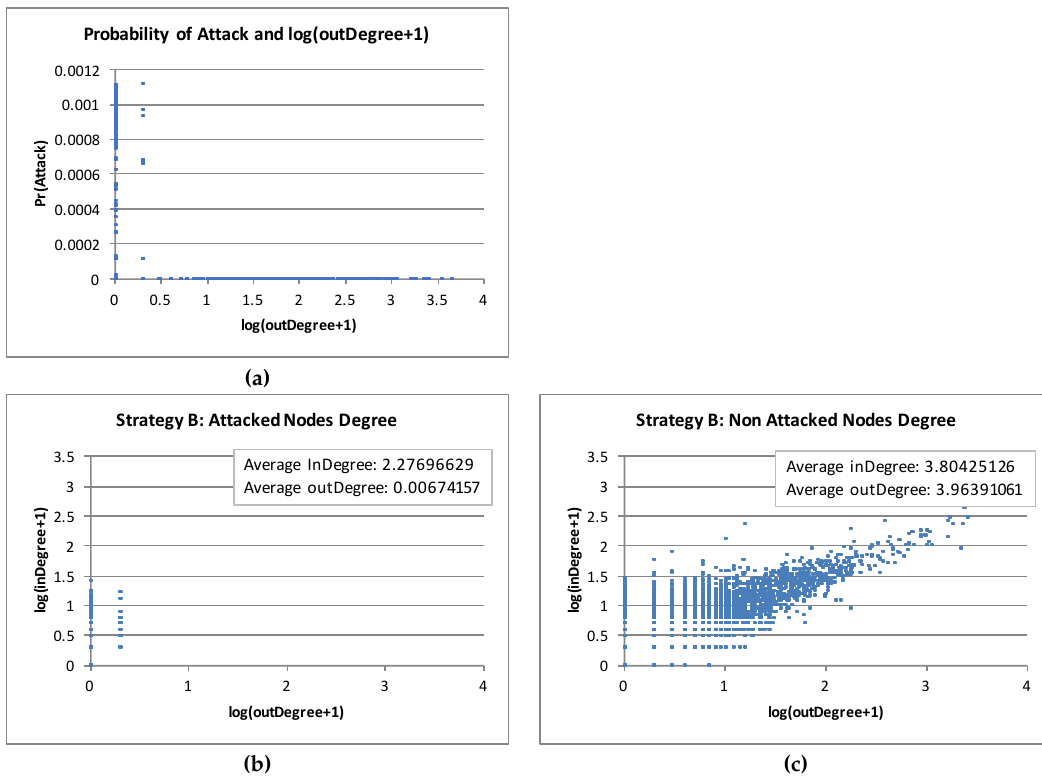
Figure 5. Attacker’s Equilibrium Strategy and the Degrees of the Nodes. The top graph ( a ), which depicts Strategy A (all 27106 nodes), shows the probability of attack ( y -axis) of a node and its corresponding outdegree ( x -axis) in logarithmic (base 10) scale. The bottom graphs, ( b ) and ( c ), show the indegree ( y -axis) of a node and its corresponding outdegree ( x -axis) in logarithmic (base 10) scale of Strategy B: the graphs on the left and right consist of the (1780) nodes with nonzero probability of attack and the (25326) nodes with zero probability of attack,